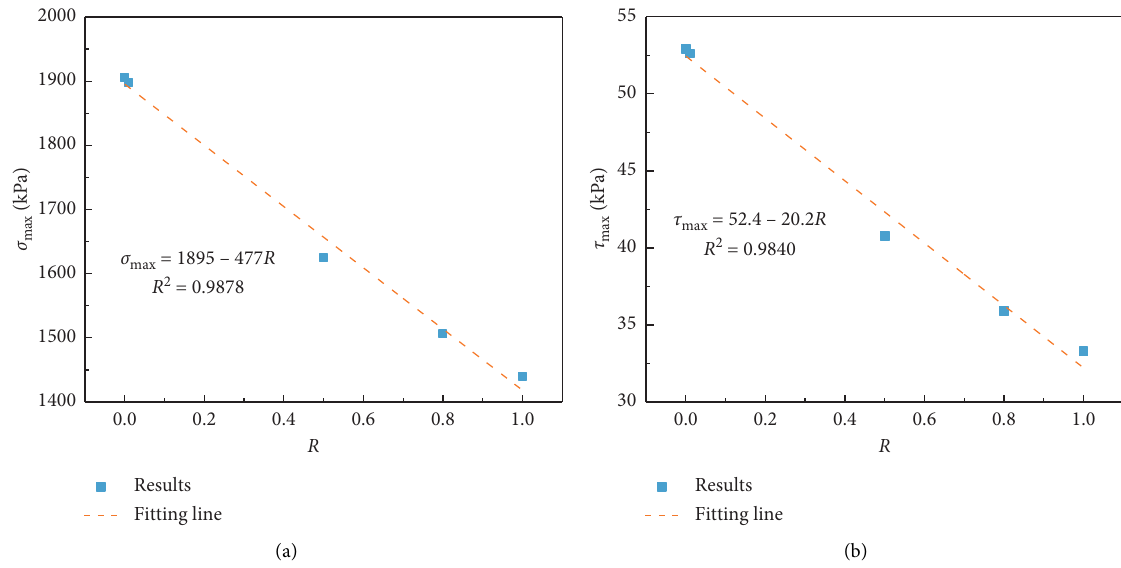
Figure 7: Effects of different R values on the maximum normal stress (a) and maximum shear stress (b) of the dangerous